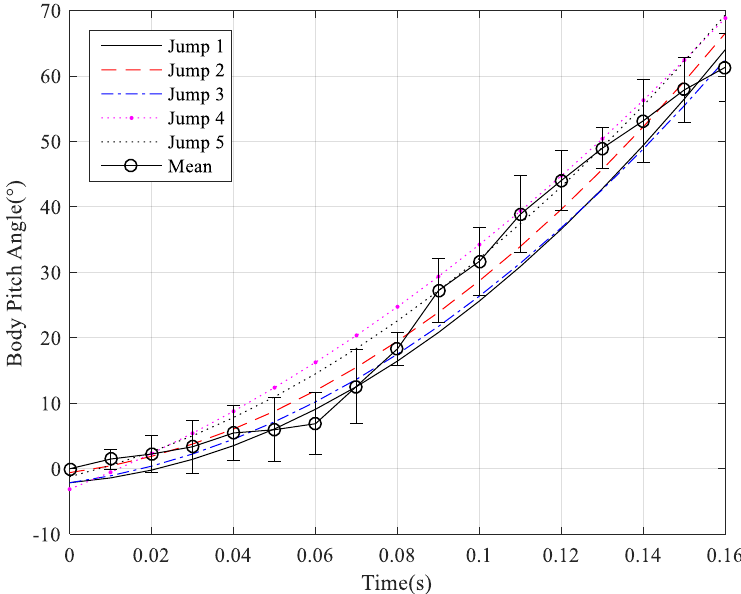
Figure 25. Experimental results for pitching adjustment when the forelimbs are not actuated.